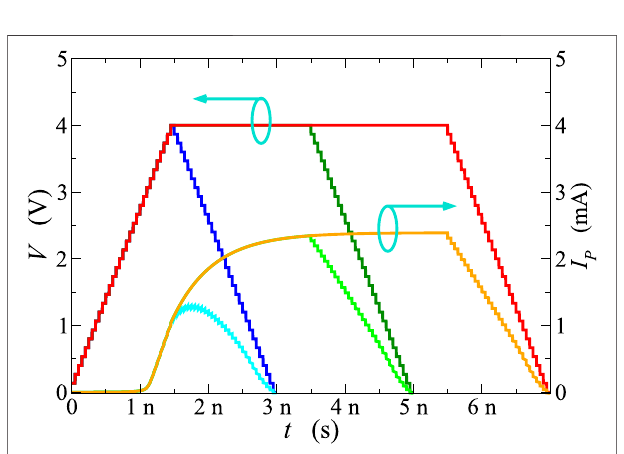
FIGURE 7 | Current fl owing across the PCM device as a function of time (rightscale)aftertheapplicationofvoltagetrapezoidalpro fi lesof4 Vamplitude (left scale). Rise and fall times are 1.5 ns in all cases, whereas the plateau durations are 0, 2, and 4 ns.